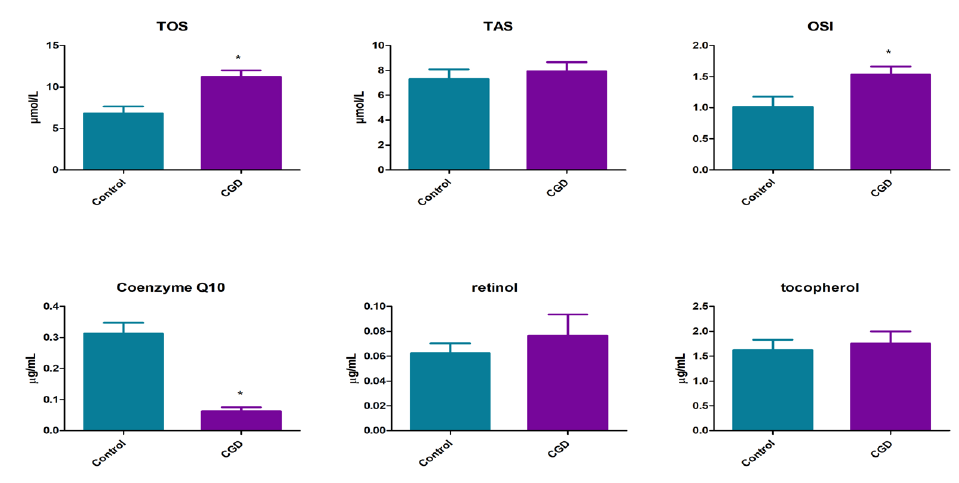
Figure 2. Redox status and plasma lipophilic antioxidants in patients with CGD as well as healthy controls. TOS, total oxidant status; TAS, total antioxidant status; OSI, oxidative stress index. Differences statistically significant at * p < 0.05.